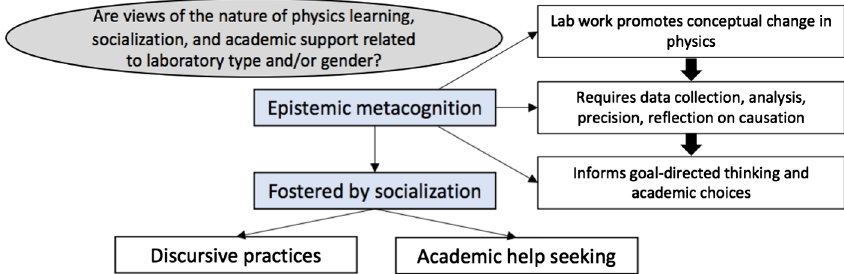
FIG. 1. Theoretical considerations for comparison of in-person and online learning